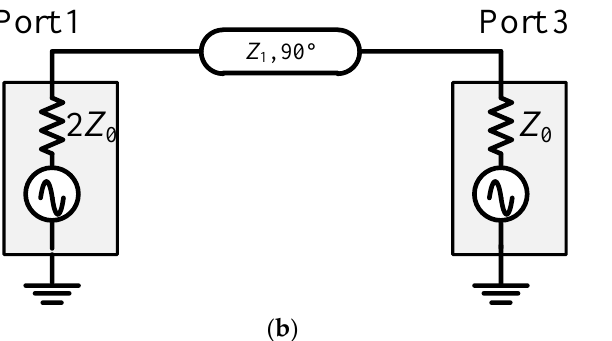
Figure 2. Schematic of the even − mode circuits between ( a ) Port 1 and Port 2 and ( b ) Port 1 and Port 3.